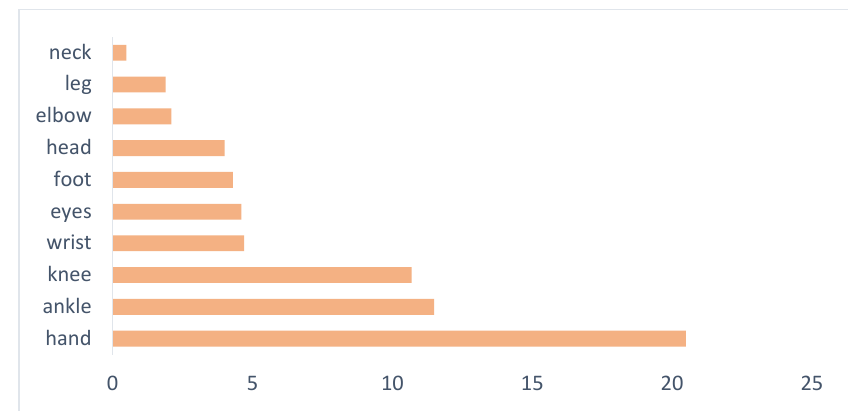
Figure 3. More involved part of body in agriculture, percentage values [4].